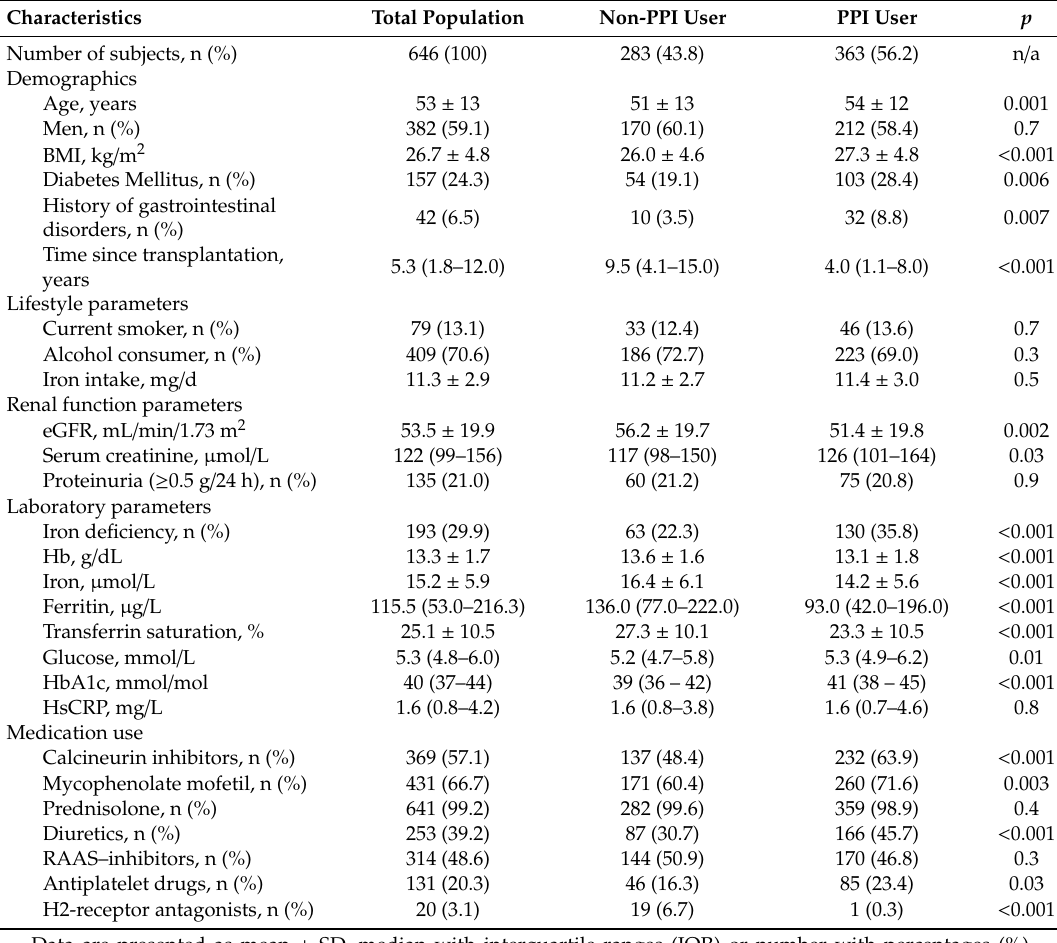
Table 1. Baseline characteristics of 646 renal transplant